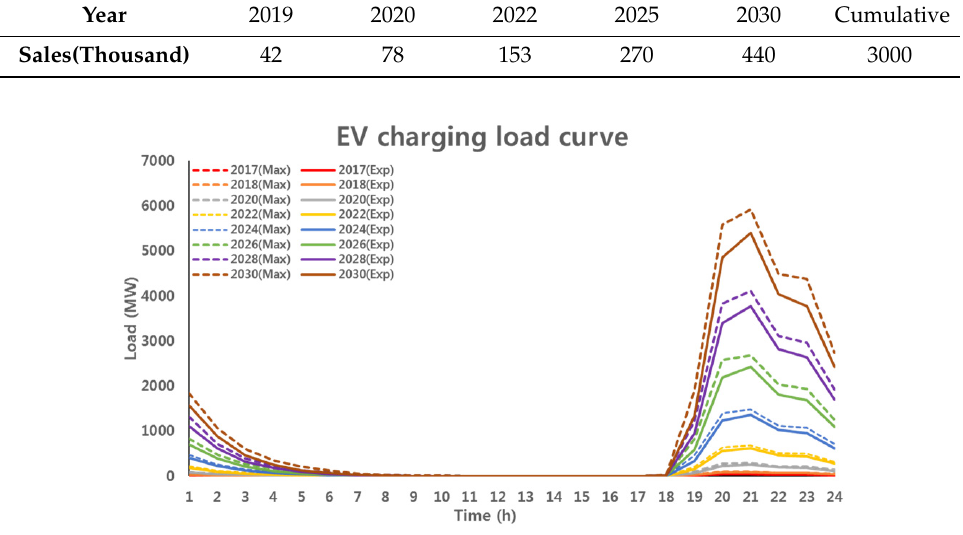
Figure 9. The predicted EV charging load curve from 2017 to 2030.